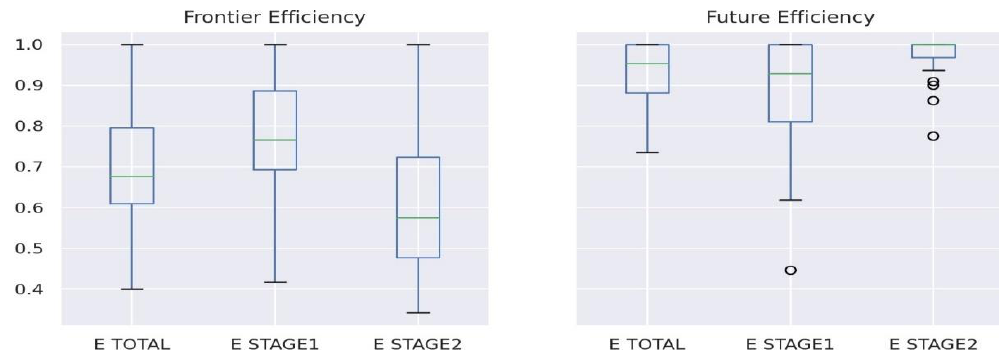
Figure 8. Box plot of the predicted efficiencies.